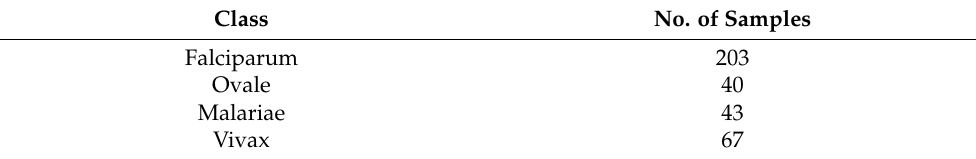
Table 1. Distribution of the number of samples between classes for parasite classification dataset.